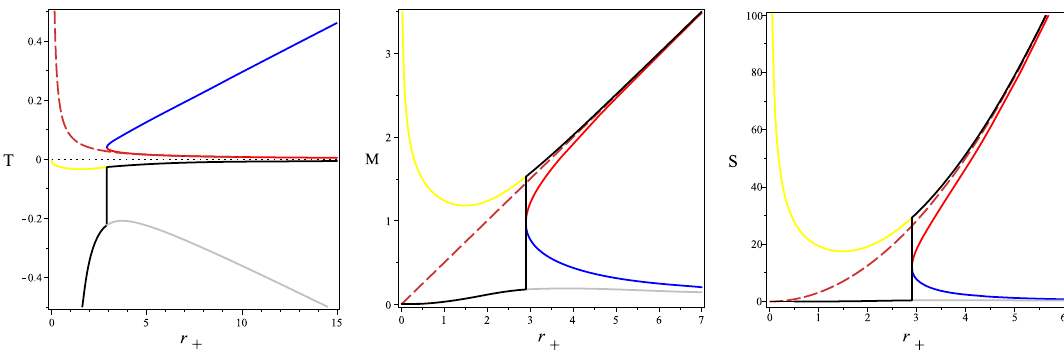
Fig. 9 The temperature, entropy and mass as a function of r + for c 1 = α = − 0 . 5. The orange dashed lines related to the Schwarzschild’s black hole Fig. 10 The free energy and heat capacity as a function of r + for c 1 = α = − 0 . 5. The orange dashed lines related to the Schwarzschild’s black